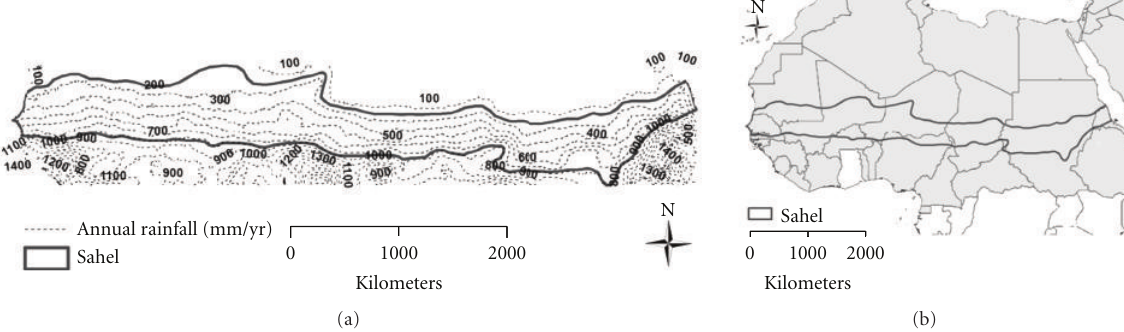
Figure 1: Delineation of the Sahel based upon the 150 and 700 mm rainfall isohyets. Based on the National Weather Service Climate Prediction Center, African Rainfall Estimates (RFE) annual mean rainfall